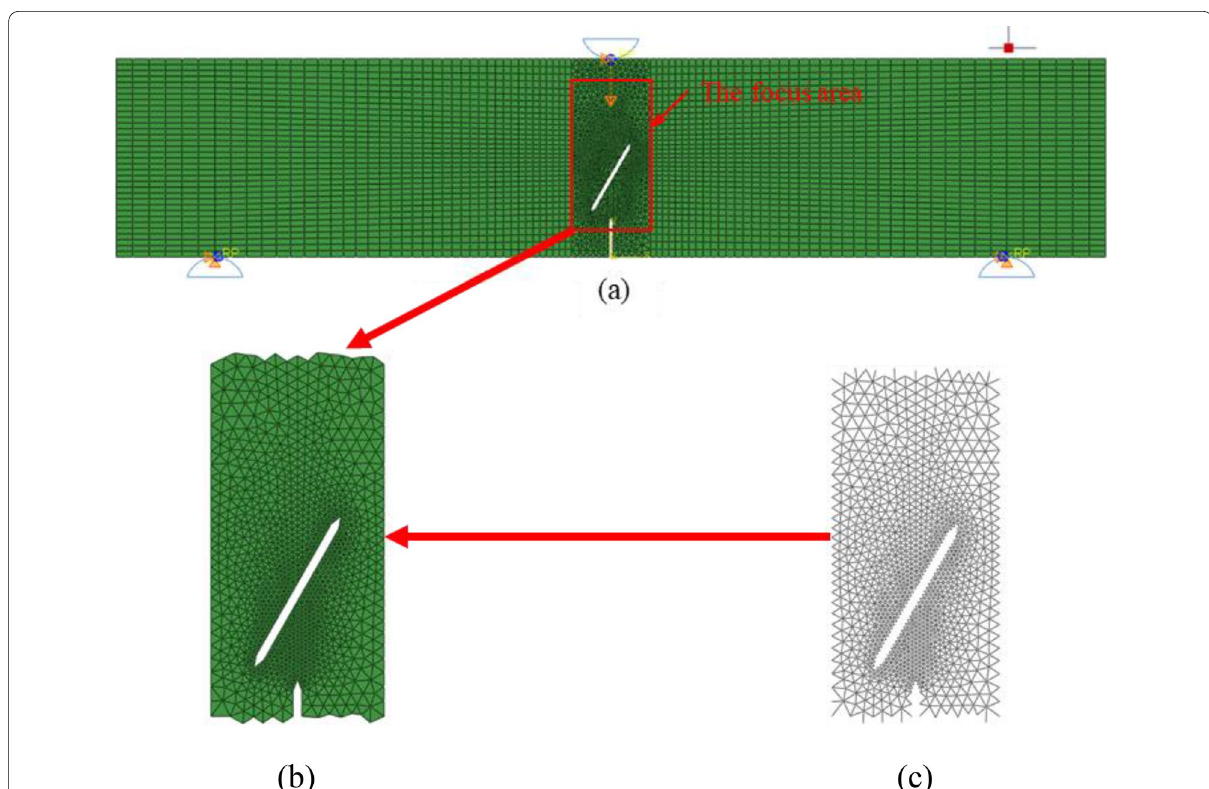
Fig. 8 Numerical model of the specimen TPB‑A30‑T1: ( a ) geometric model and boundary conditions, ( b ) initial finite elements of the focus area, and ( c ) the zero thickness cohesive elements